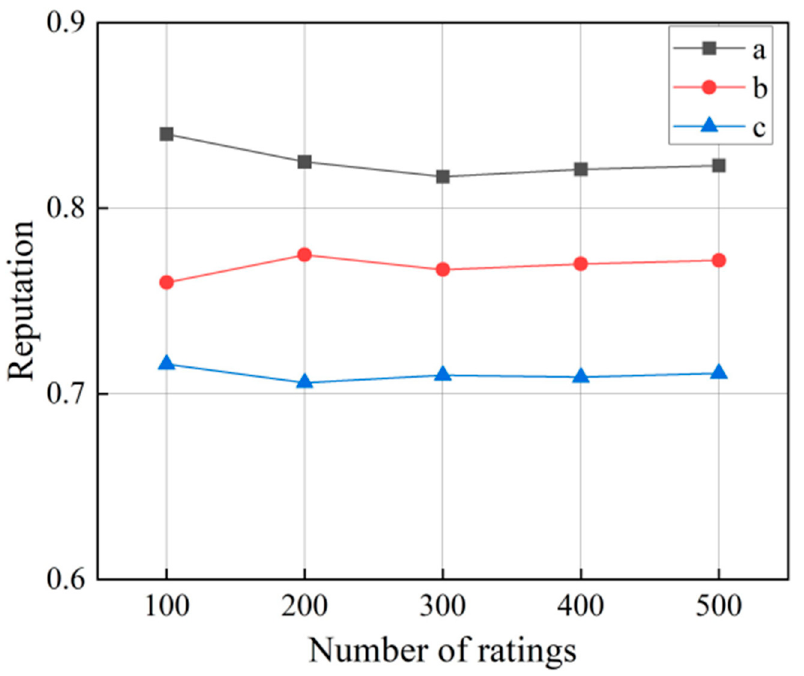
Figure 9. User reputation